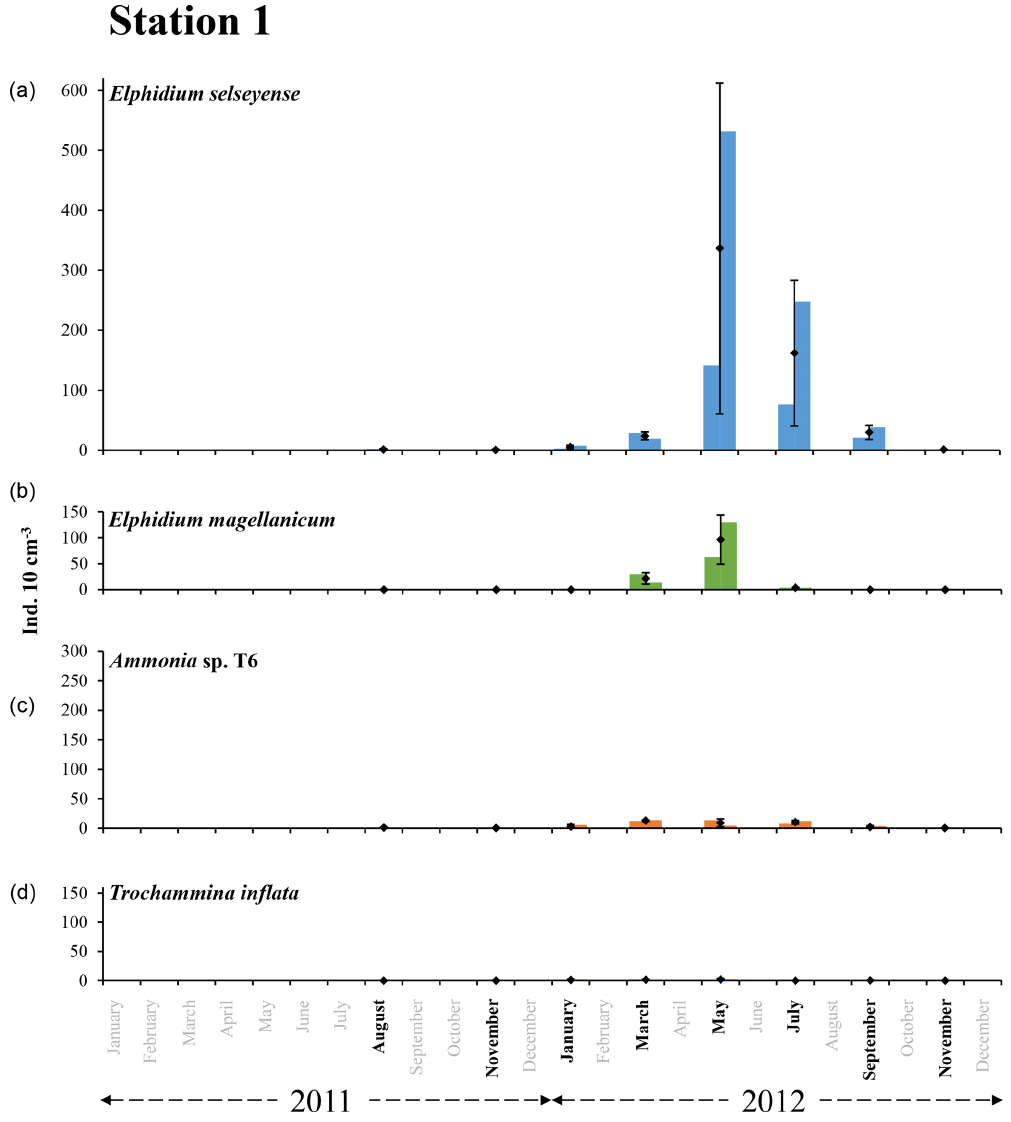
Figure 5. The bars represent the living foraminiferal abundances for the two replicates for Elphidium selseyense (a) , Elphidium magellanicum (b) , Ammonia sp. T6 (c) and Trochammina inflata (d) at station 1 in 2011 and 2012. The mean abundances (diamonds) and standard deviations (black error bars) were calculated for the two replicates. All abundance values are for the 0–1cm layer and were standardised to 10cm 3 . Months when foraminiferal communities were investigated are indicated in bold. Scales were chosen in order to facilitate comparison with station